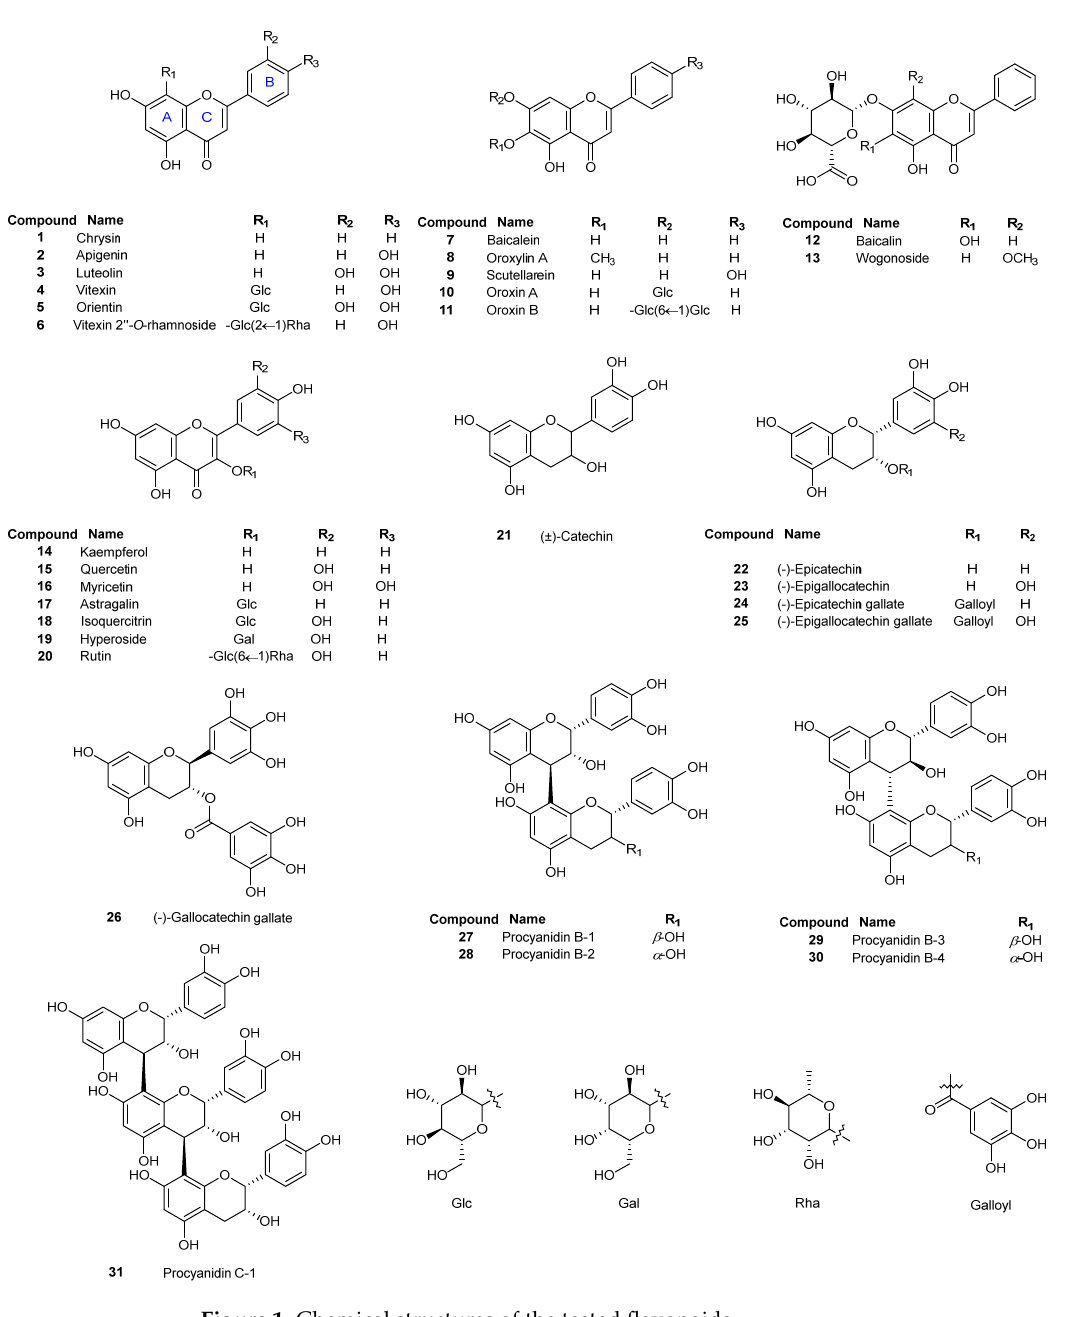
Figure 1. Chemical structures of the tested flavonoids.